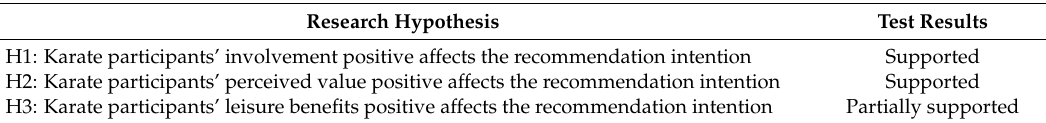
Table 8. Test results of research